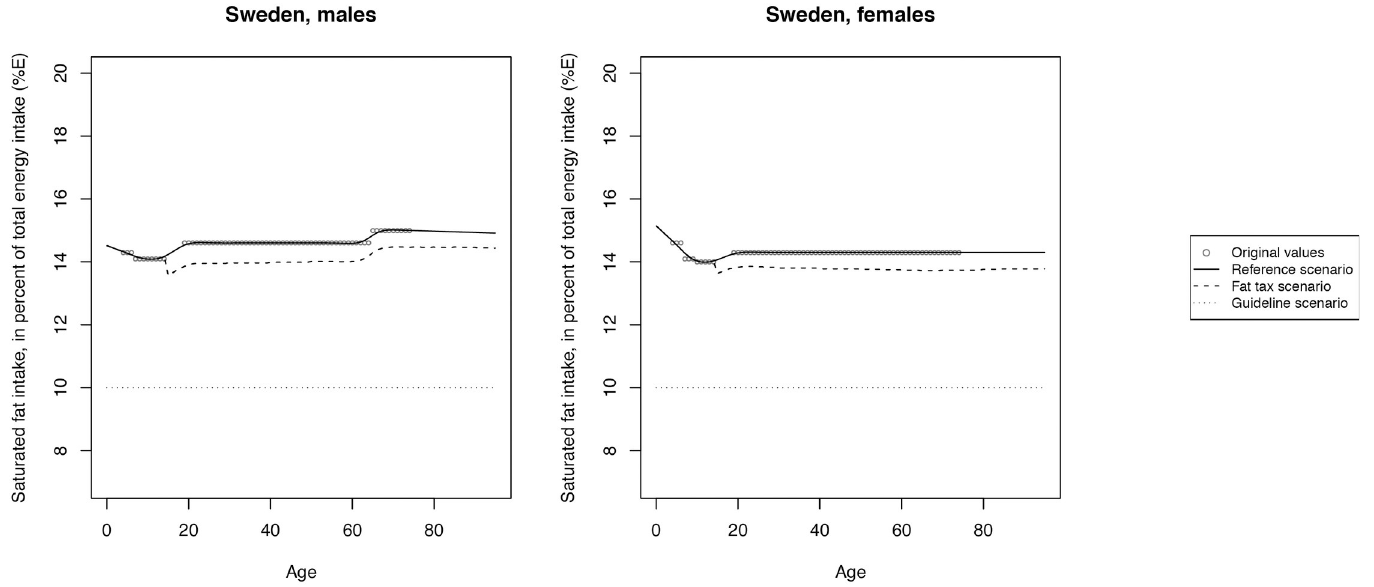
Fig 7. Mean saturated fat intake across reference, fat tax and guideline scenario in Sweden.